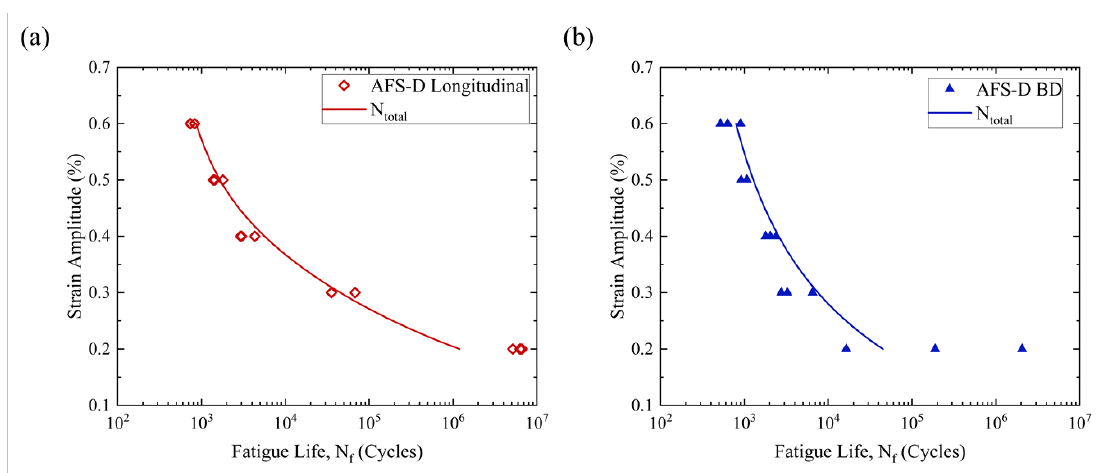
Figure 8. Microstructure-sensitive fatigue (MSF) model fit for ( a ) AFS-D as-deposited AA6061 in the longitudinal direction and ( b ) AFS-D as-deposited AA6061 in the build